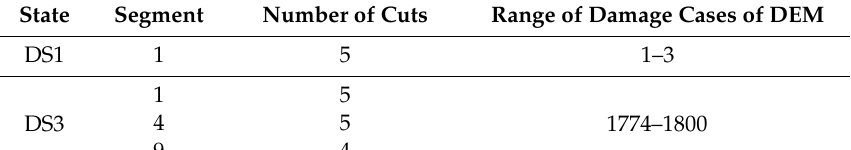
Table 5. Damage state [45] and the range of corresponding damage cases.